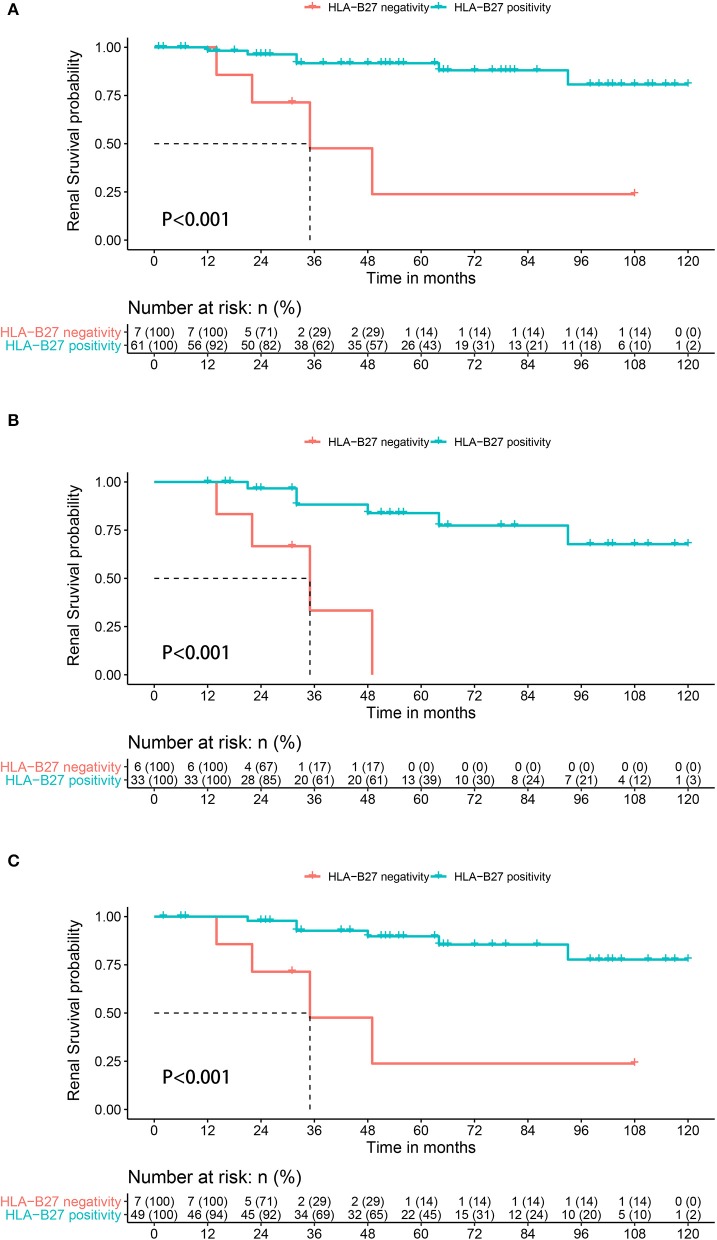
Kaplan-Meier survival plots for renal function decline during follow-up depending on the presence or absence of HLA-B27 in AS patients with IgAN (A) whole population, (B) in the subgroups of patients with proteinuria at >1.0 g per day, and (C) in the subgroups of patients with interstitial fibrosis and tubular atrophy.